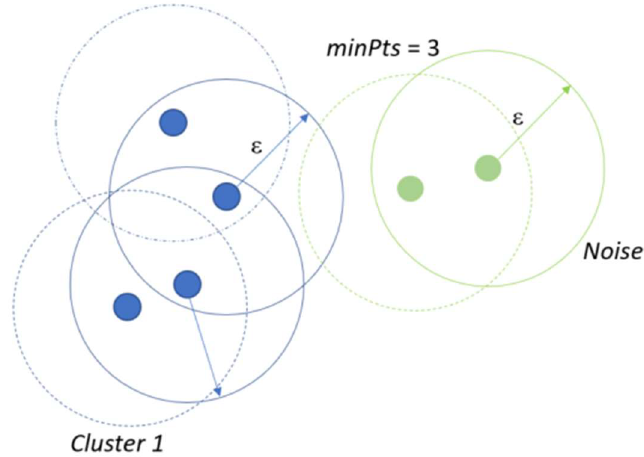
Figure 7. Clustering with the Density-Based Spatial Clustering of Applications with Noise (DBSCAN) algorithm.